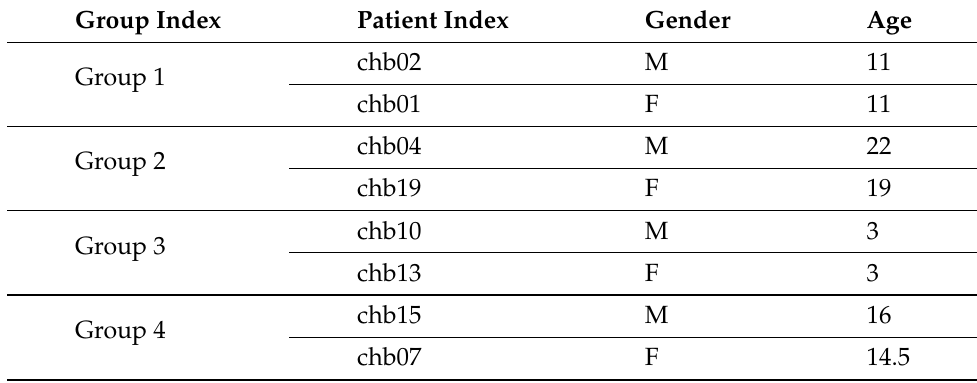
Table 8. Eight patients were selected from CHB-MIT and divided into four